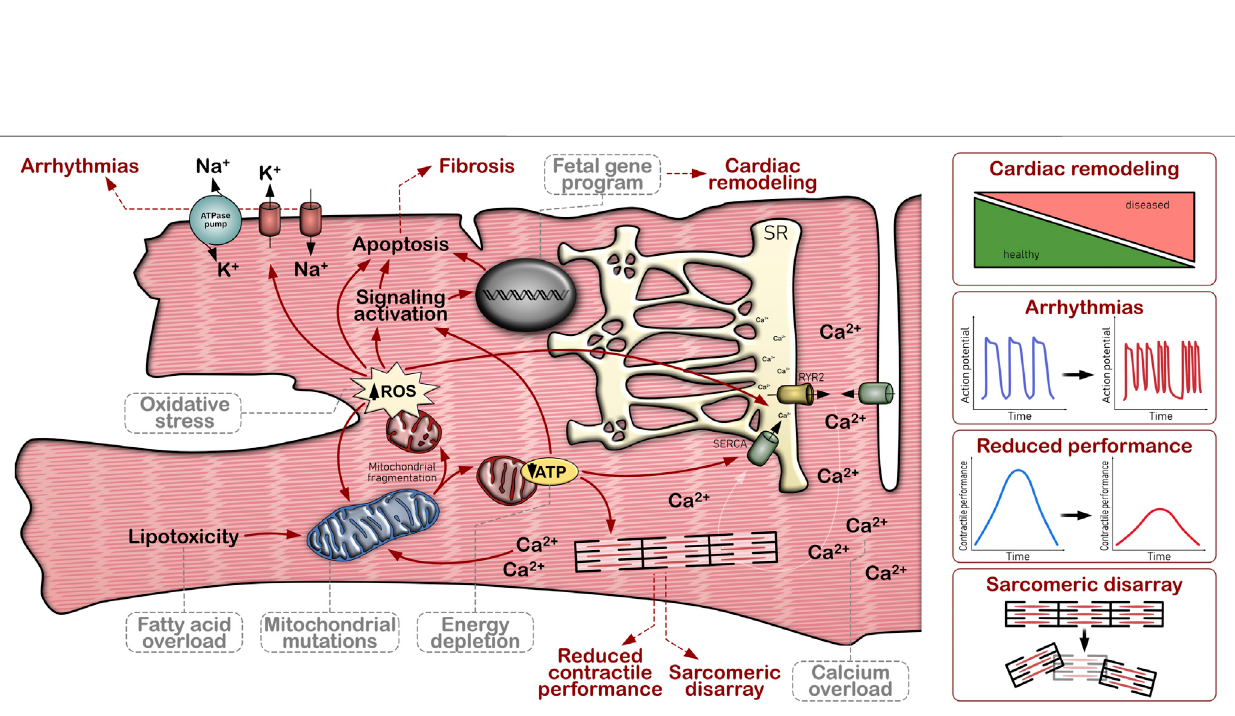
2021). As a consequence of this event, daughter cells can receive a